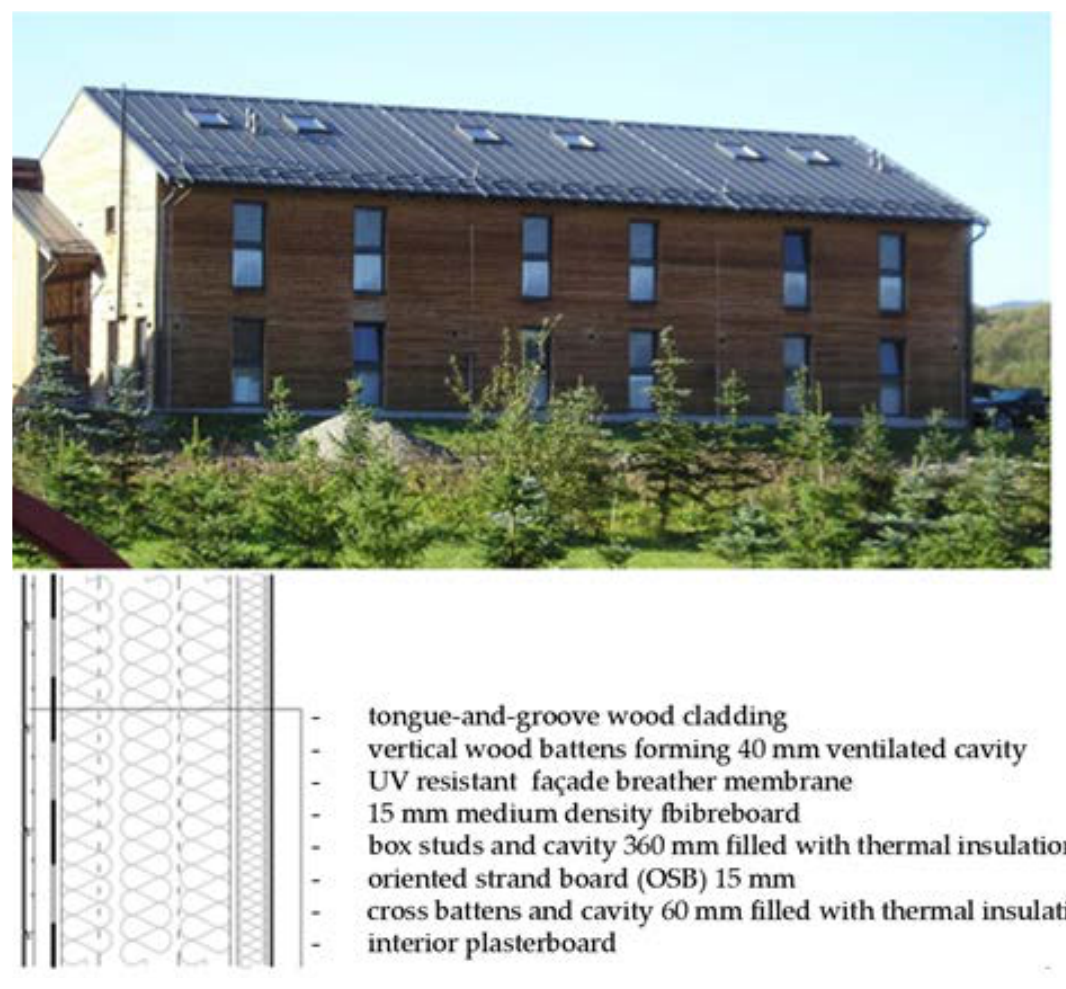
Figure 1. Wooden façades of boarding house in Demänov á , Slovakia. Wooden structure of the exterior wall